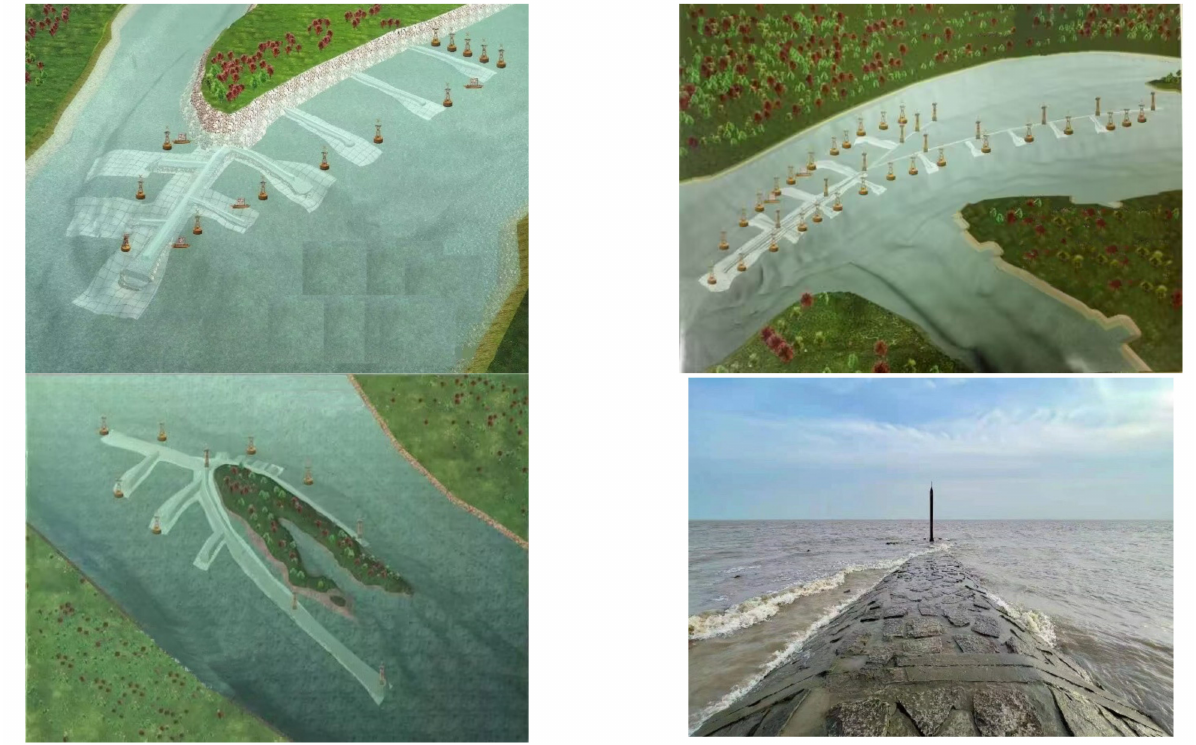
Figure 1. Submerged spur dike in the Yangtze River below